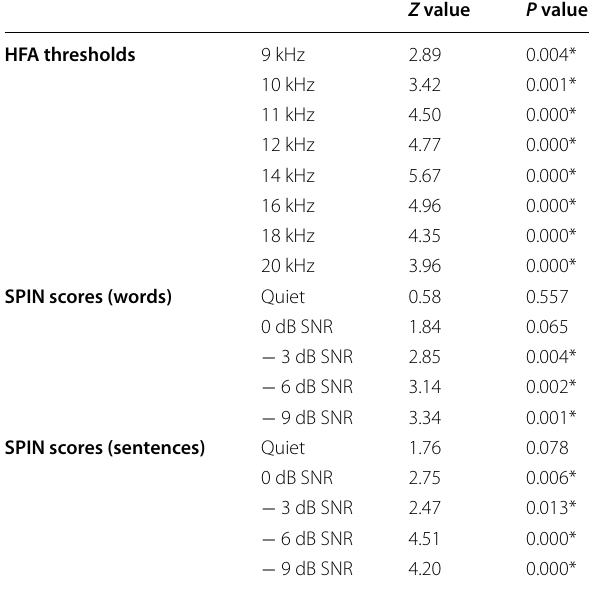
*Significant difference between the